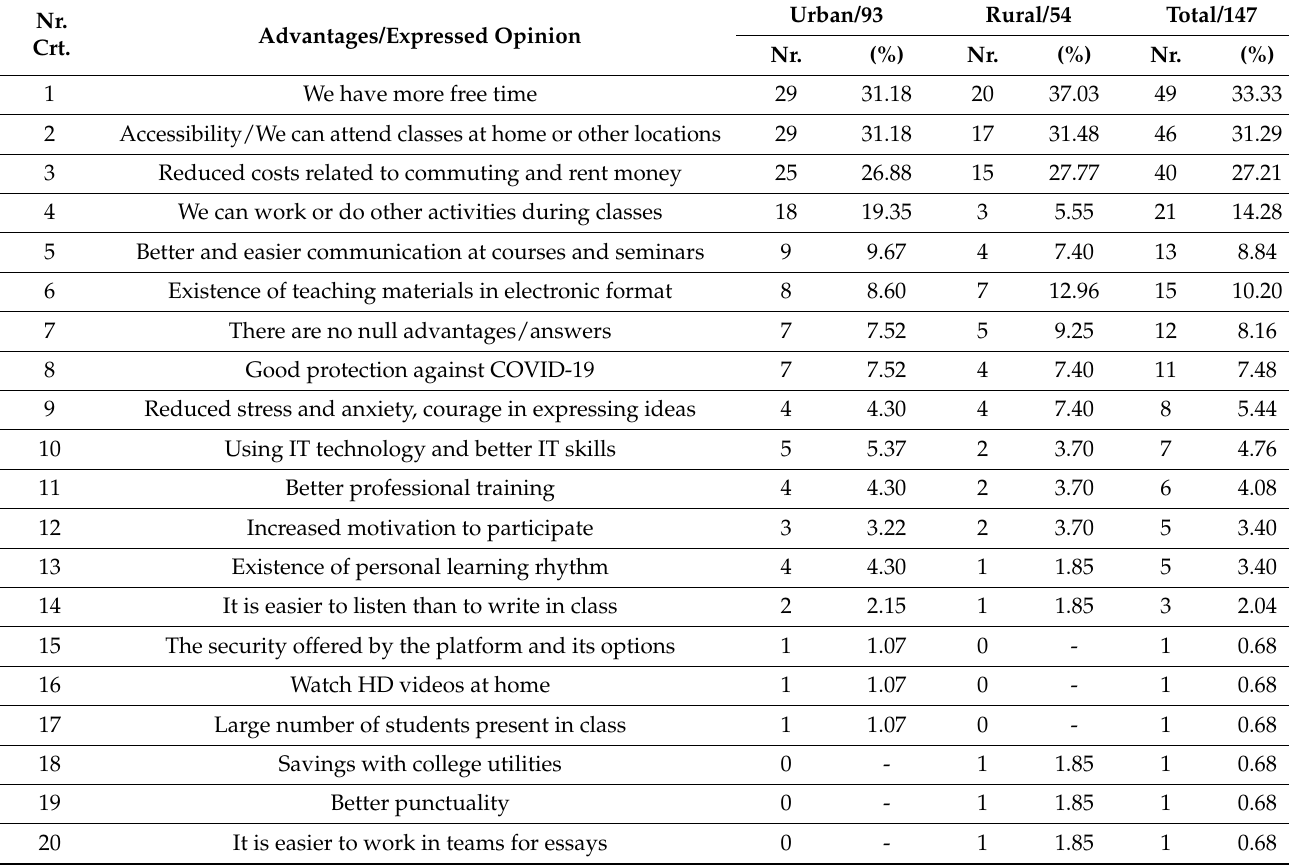
Table 5. Ordering the advantages offered by the online activity based on the source